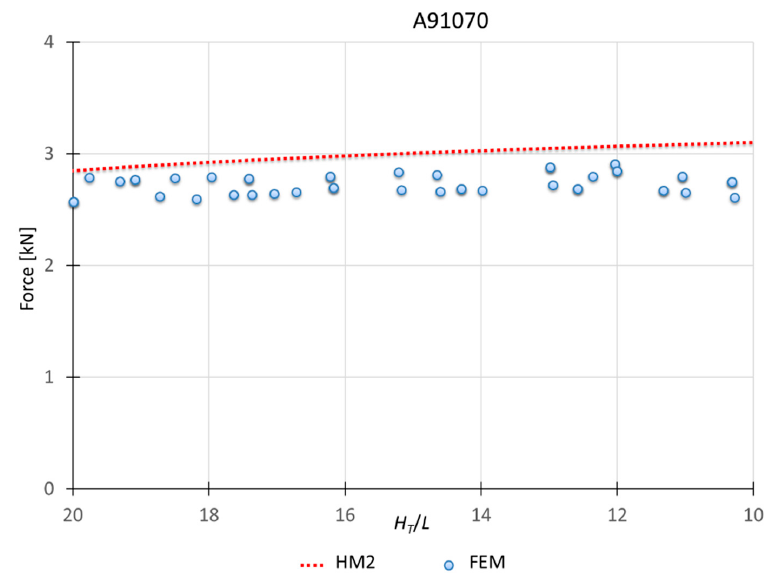
Figure 10. MUBT-FEM comparison for A91070, n = 0.21.